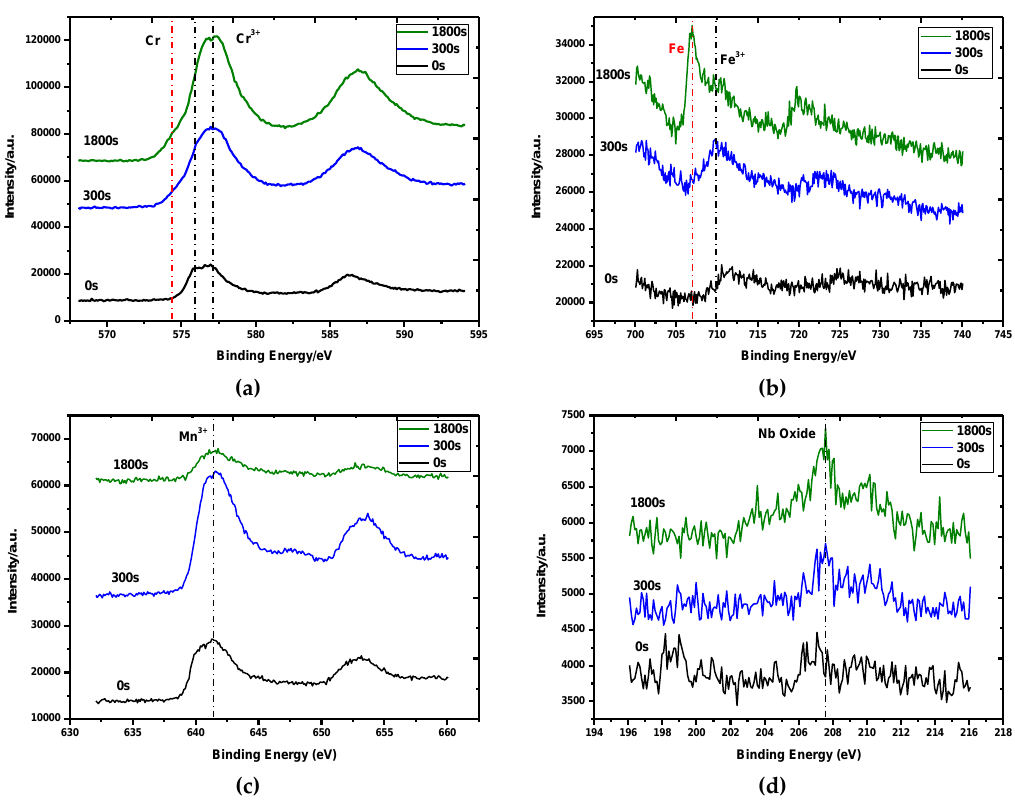
Figure 13. XPS results of the oxide scale of TP347HFG at 700 °C after 168 h. ( a ) Cr 2p 3/2 ; ( b ) Fe 2p 3/2 ; ( c ) Mn 2p 3/2 ; ( d ) Nb 3d.